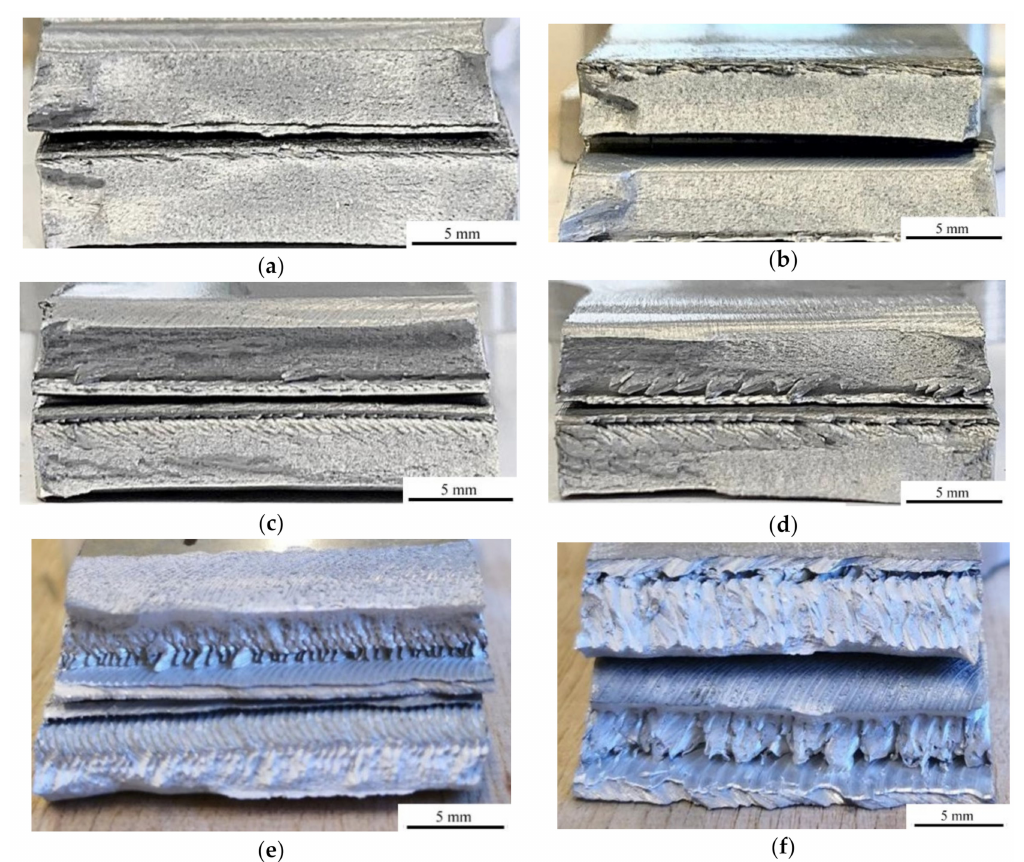
Figure 6. Fractographic images: ( a ) CR2; ( b ) CR3; ( c ) CR4; ( d ) CR5; ( e ) TR2; ( f )